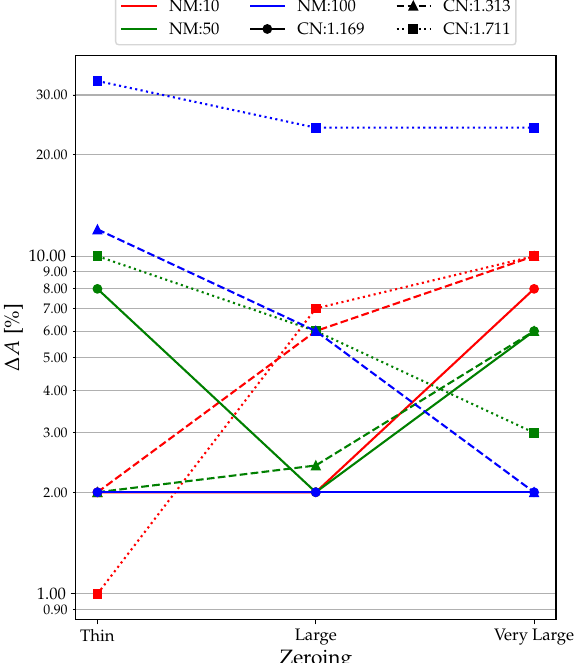
Figure 15. Zeroing Analysis: ∆ A results.